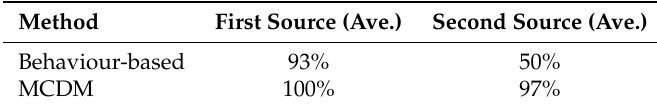
Figure 10. The number of stops required for the gamma camera to give a radiation image in the environment B, average over ten trials. Table 4. The likelihood of hotspot detection, average over ten